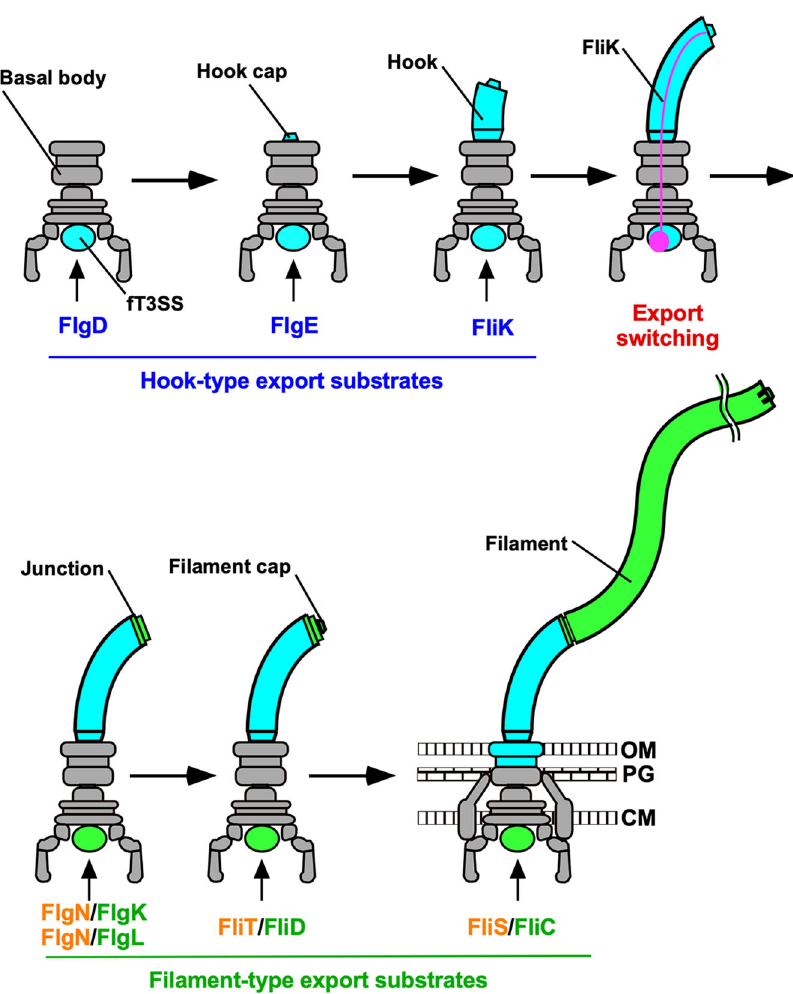
Fig. 1 Flagellar assembly pathway. The Salmonella fl agellum is composed of the basal body, the hook, the hook – fi lament junction, the fi lament and the fi lament cap. Upon completion of basal body assembly, newly exported FlgE molecules polymerize into the hook structure with the help of the hook cap made of FlgD. When the hook reaches its mature length of about 55 nm, the hook cap is replaced by FlgK. FlgK and FlgL self-assemble at the hook tip in this order to form the junction structure. Then, FliD forms the fi lament cap at the tip of the junction and promotes the assembly of FliC into the fi lament. A type III protein export apparatus (fT3SS) is located at the fl agellar base and transports fl agellar building blocks from the cytoplasm to the distal end of the growing fl agellar structure. The fT3SS sometimes secretes the FliK ruler to measure the hook length during hook assembly. When the hook reaches its mature length of about 55 nm, the fT3SS switches its substrate speci fi city, thereby terminating the export of hook-type proteins (FlgD, FlgE, and FliK) and initiating the export of fi lament-type proteins (FlgK, FlgL, FliD, and FliC). FlgN, FliT, and FliS act as fl agellar type III export chaperones speci fi c for FlgK and FlgL, FliD and FliC, respectively. OM outer membrane, PG peptidoglycan layer, CM cytoplasmic